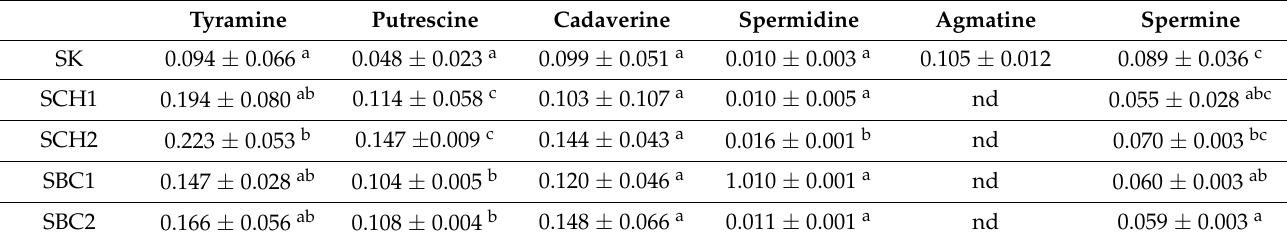
Table 3. The biogenic amines content at 30 day of manufacturing process of dry fermented sausages [mg g − 1 ]. Tyramine Putrescine Cadaverine Spermidine Agmatine Spermine